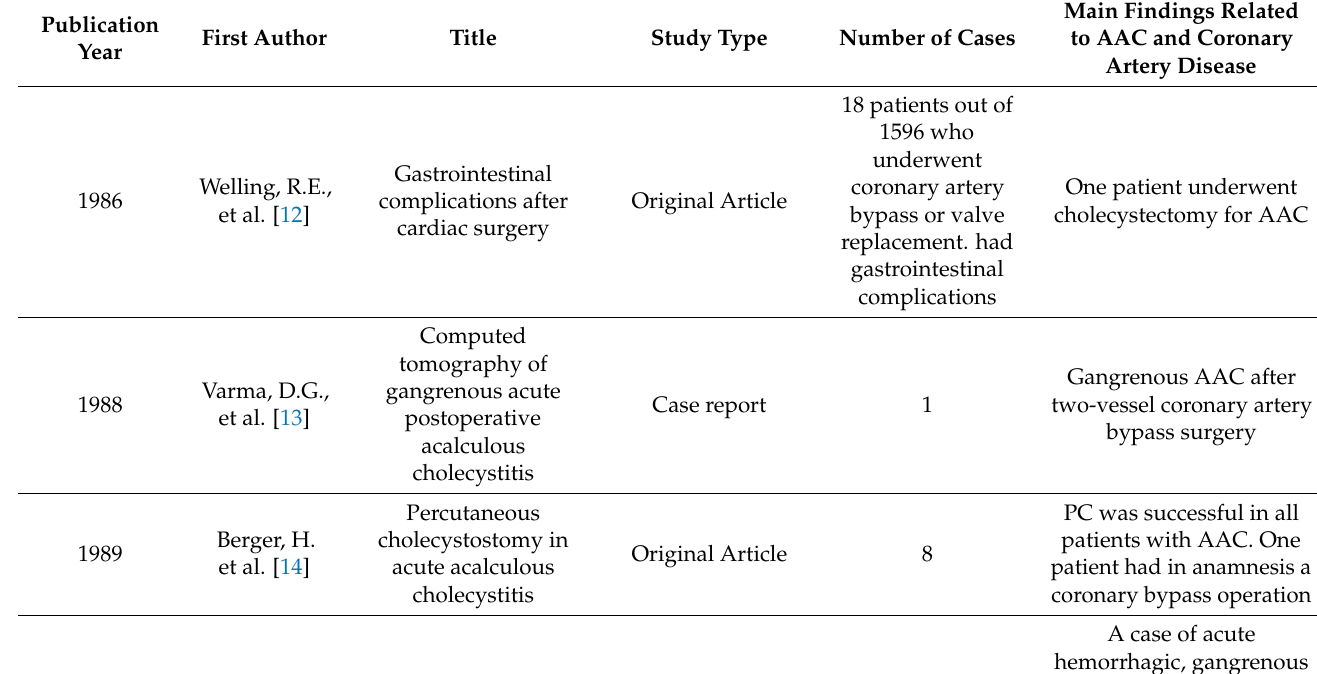
Table 1. Summary of the records collected by a brief Pubmed literature search using the keywords “(acute acalculous cholecystitis) AND (coronary artery